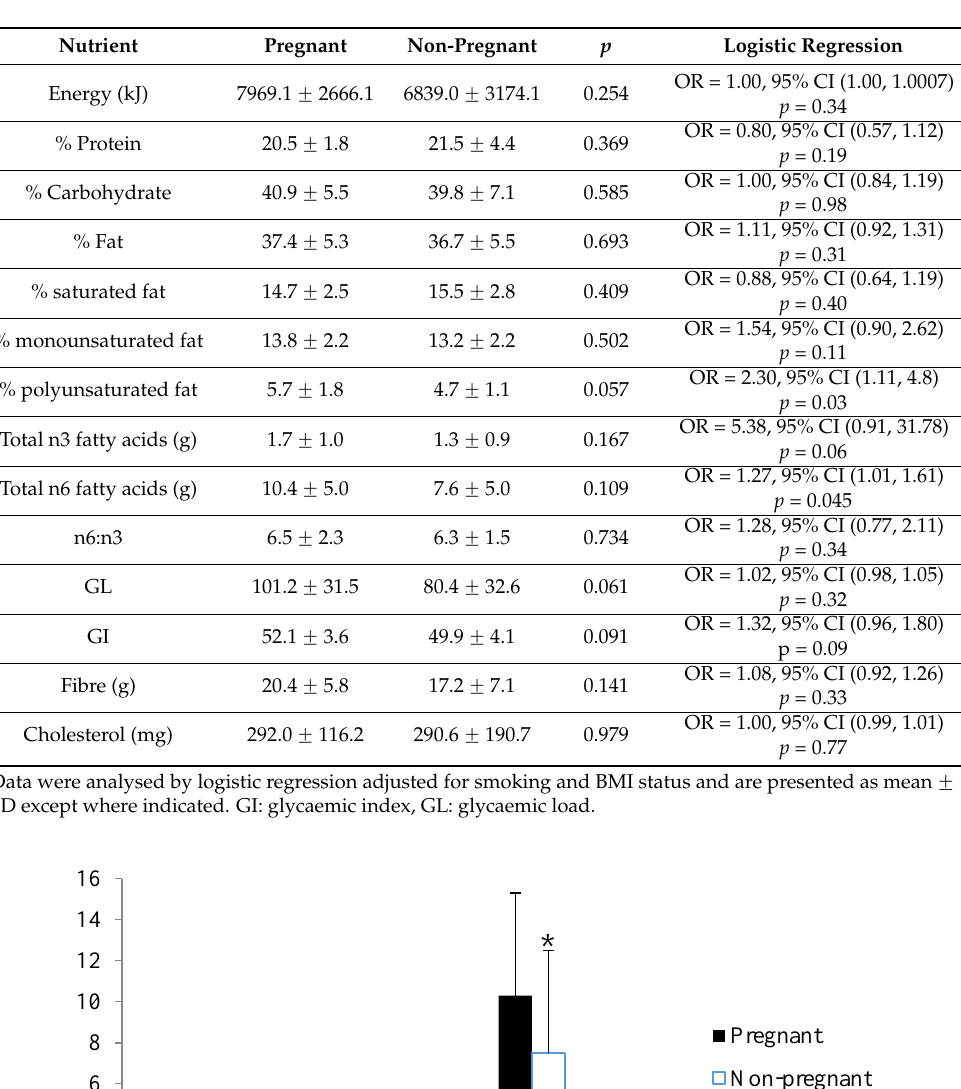
Table 2. Dietary intake over the prior 12 months for women who did and did not become pregnant during the intervention.